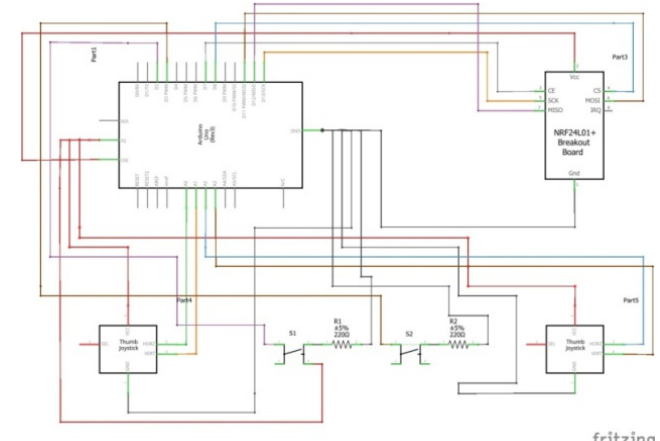
Fig. 13. Schematic diagram of transmitter unit